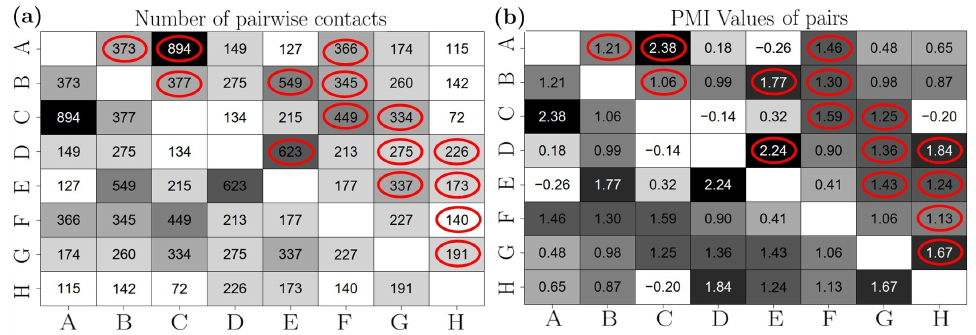
Figure A1. Matrix of the number of pairwise heifer contacts ( a ) and the corresponding PMI values ( b ). The red circles indicate that after APC procedure, the two entries formed an edge in the social network. Although the matrices are symmetric, we show all values to enable a better understanding of the functionality of PMI and the APC procedure. The background colors simplify the interpretation of the matrix; dark colors indicate high values and vice